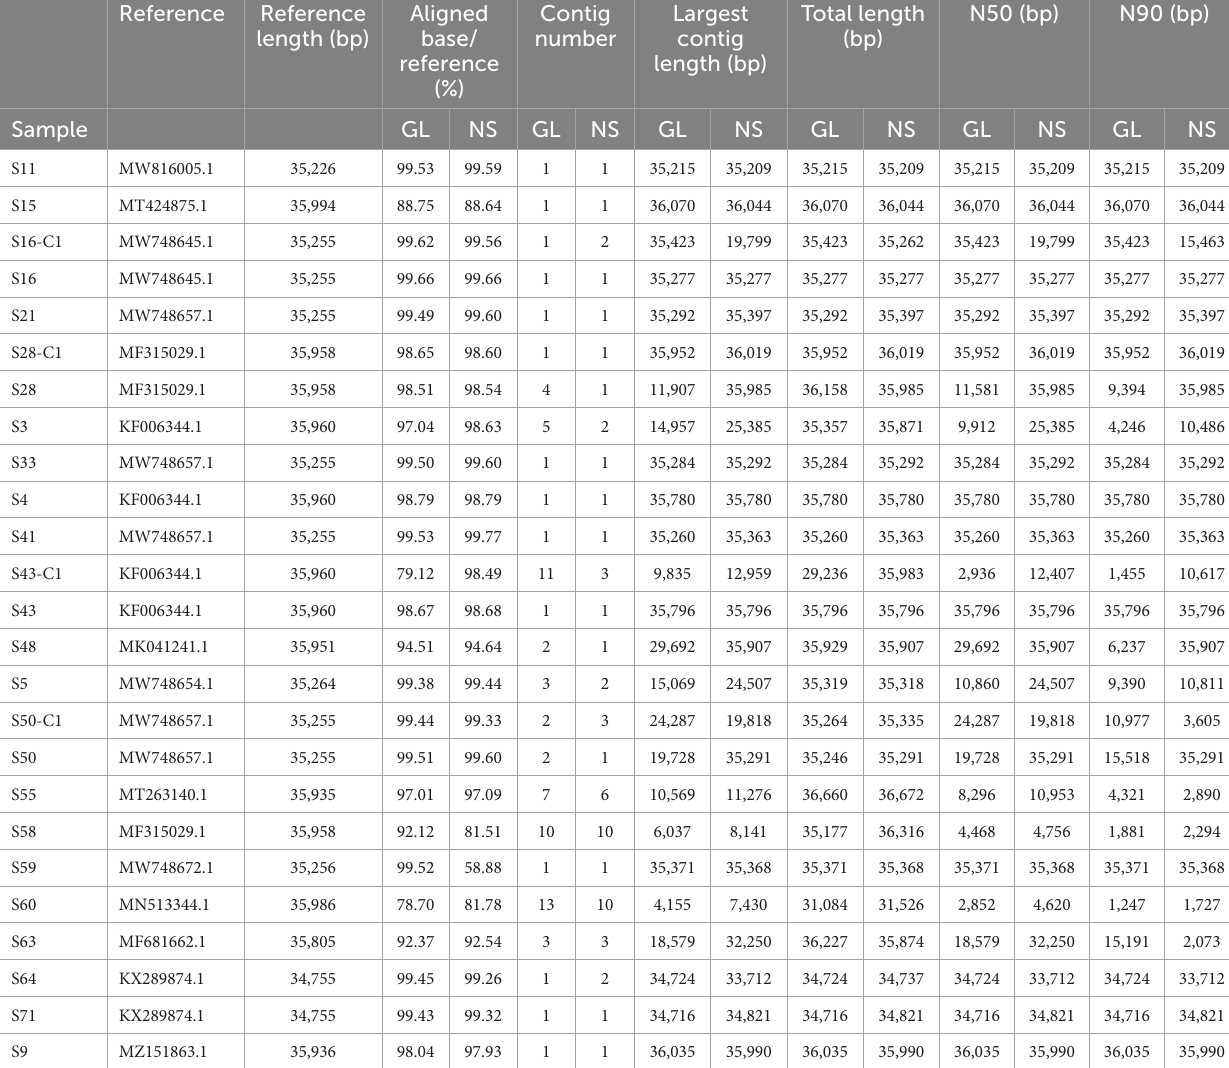
TABLE 1 Assembly statistics of 25 samples sequenced via two